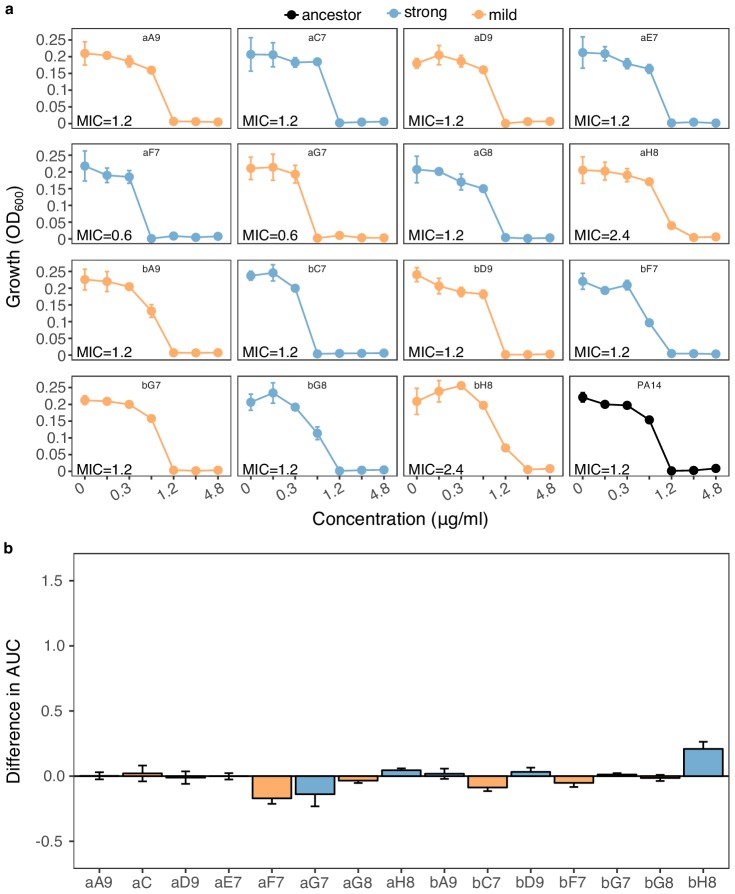
Re-sensitization to gentamicin (GEN) upon adaptation to carbenicillin (CAR).We calculated (a) dose-response relationships against GEN of 15 populations adapted to strong (n = 7, light blue) and mild (n = 8, light orange) drug increases compared to the PA14 ancestor (black, bottom-right panel). Mean ±CI95, n = 3 technical replicates. In most cases, the evolved population had the same MIC as PA14. Two populations (aF7 and aG7) showed lower MICs than PA14, while two (aH8 and bH8) showed slightly higher ones. The labels within each graph correspond to the code used during experimental evolution. Data from Source Data 4 (b) Difference in the area under the curve (AUC) between each evaluated population and the PA14 ancestor. Scaling of the y-axis is equivalent to Figure 3d. None of the populations was significantly different from the ancestor (Wilcoxon’s test, n = 3, adjusted P values min > 0.4, and max <0.9). The data for this figure are provided in Figure 3—figure supplement 2—source data 1; Figure 3—figure supplement 2—source data 2.Figure 3—figure supplement 2—source data 1.Dose-response curves data of surviving populations adapted to unconstrained environments (strong and mild), as well as the PA14 wild type against GEN.The data is shown in Figure 3—figure supplement 2. Each population-drug concentration was evaluated in triplicate.Figure 3—figure supplement 2—source data 2.Change in resistance of populations adapted to unconstrained environments (strong and mild) relative to the PA14 wild type against GEN.The data is shown in Figure 3—figure supplement 2. The resistance change was inferred by calculating the difference between the evolved populations and the PA14 wild type in the AUC across drug concentrations.